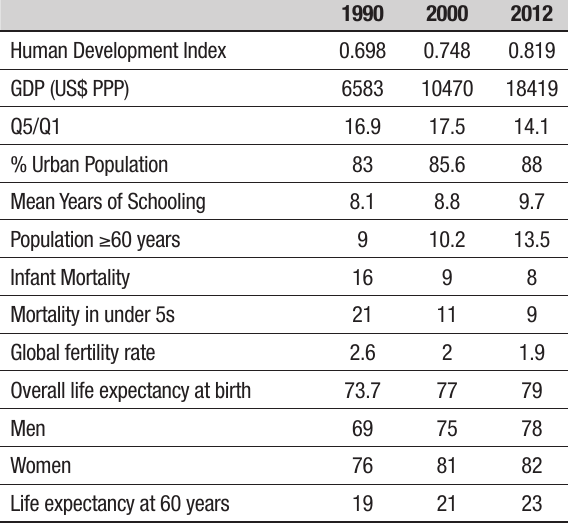
Table 1. Human development changes in Chile.